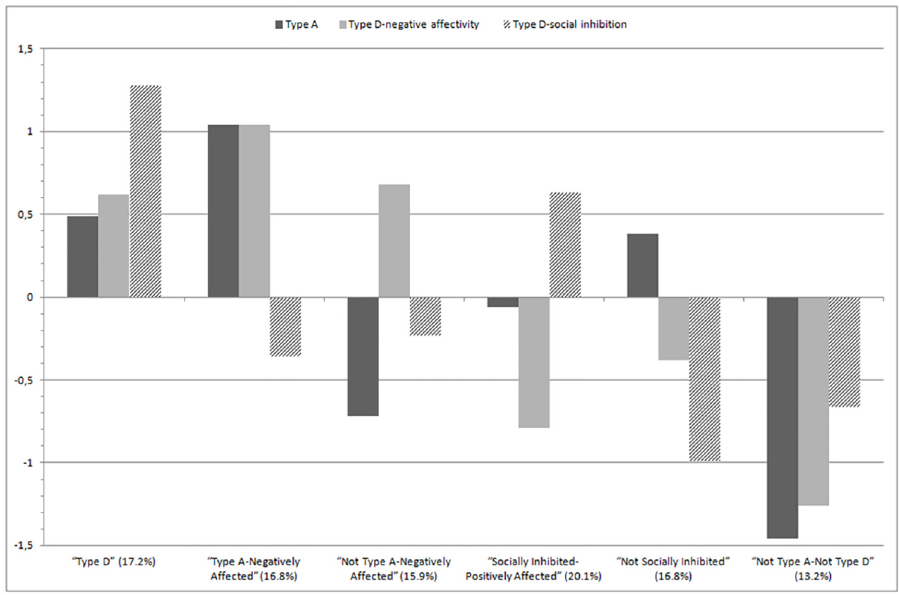
Fig 2. Z-scores for Type A, Type D-negative affectivity, and Type D-social inhibition for the final six- cluster